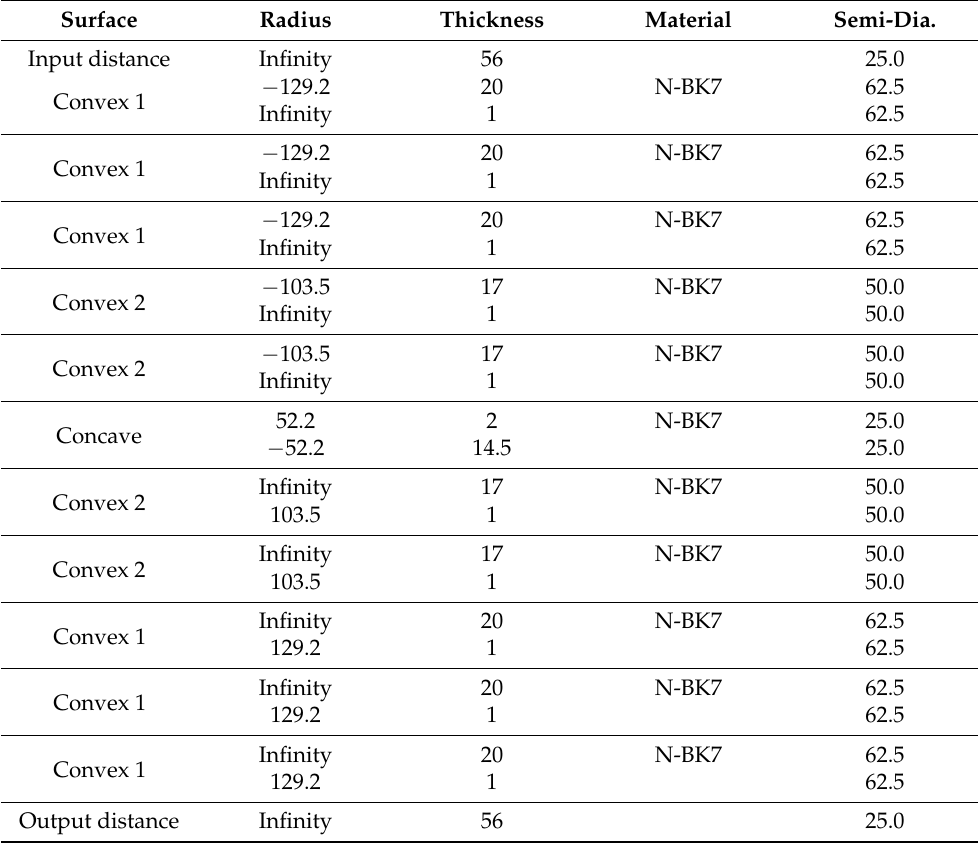
Table 1. Lens parameters of the proposed scanning optics for the dual-axis